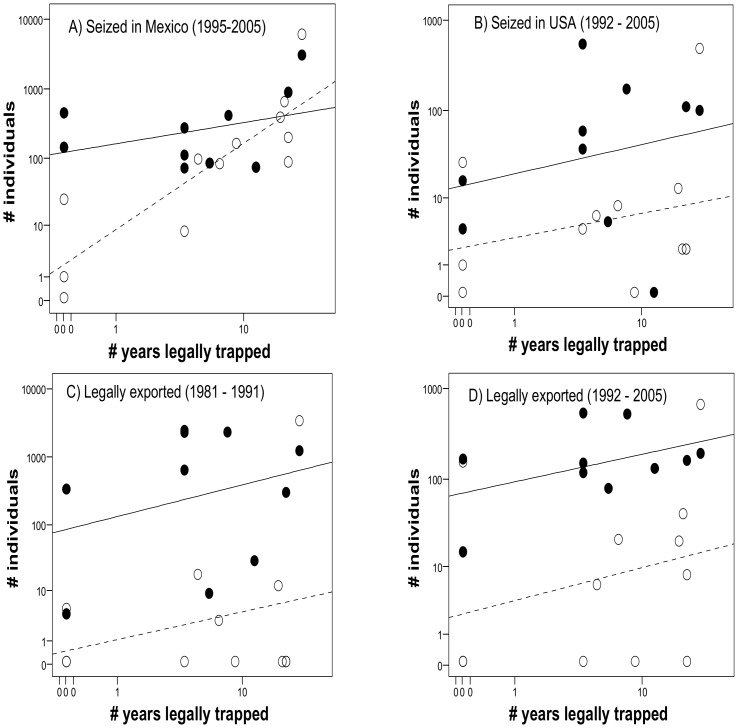
Number of Mexican parrots illegally (A and B) and legally (C and D) traded related to their attractiveness and the number of years the capture of each species was legally allowed in Mexico.Black dots represent the most attractive (Ara and Amazona) species, while empty dots represent other parrot species. Data are log-transformed since they fit a Poisson-like distribution. Regression lines are fitted for each group of species. Note that for panel D the best supported model related the number of traded parrots to their attractiveness and nest accessibility (Table 1), but the number of years legally trapped is shown for a better comparison with panels A–C.